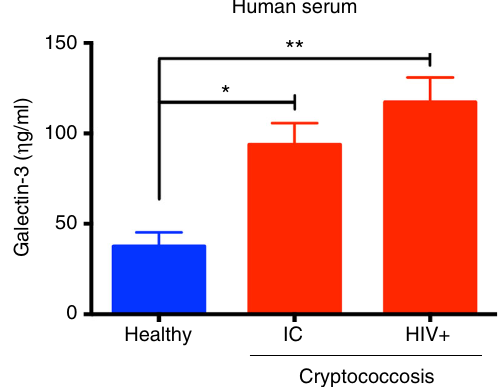
Fig. 2 Upregulated Gal-3 levels in humans during C . neoformans infection. Gal-3 levels in serum from healthy individuals (blue bar) and patients infected by C . neoformans (red bars) were assessed by ELISA. Gal-3 levels were higher in IC (immunocompetent) and HIV (human immunode fi ciency virus) patients infected with C . neoformans when compared with healthy individuals. Bars represent the mean ± SD of Gal-3 levels obtained from triplicate samples. Statistically signi fi cant differences are denoted by asterisks (* p < 0.05, ** p < 0.005, unpaired Student ’ s t -test) T-cell differentiation, namely T-bet (for Th1 cells), GATA-3 (for Th2 cells), and ROR- γ t (for Th17 cells) and found that the three transcription factors at days 3, 7, and 14 post-infection were simi- − / − mice (Fig. 5). These results sug- larly expressed in WT and gal3 gest that the Gal-3 role in the control of the C . neoformans infection promotes skewed TH17 immune response pro fi le.